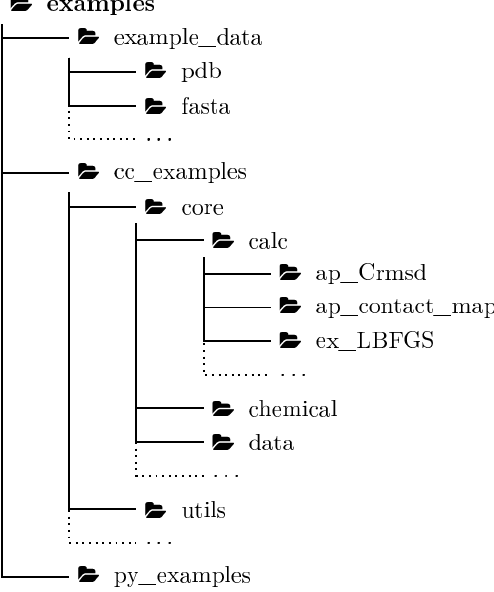
Figure 2. Organisation of BioShell